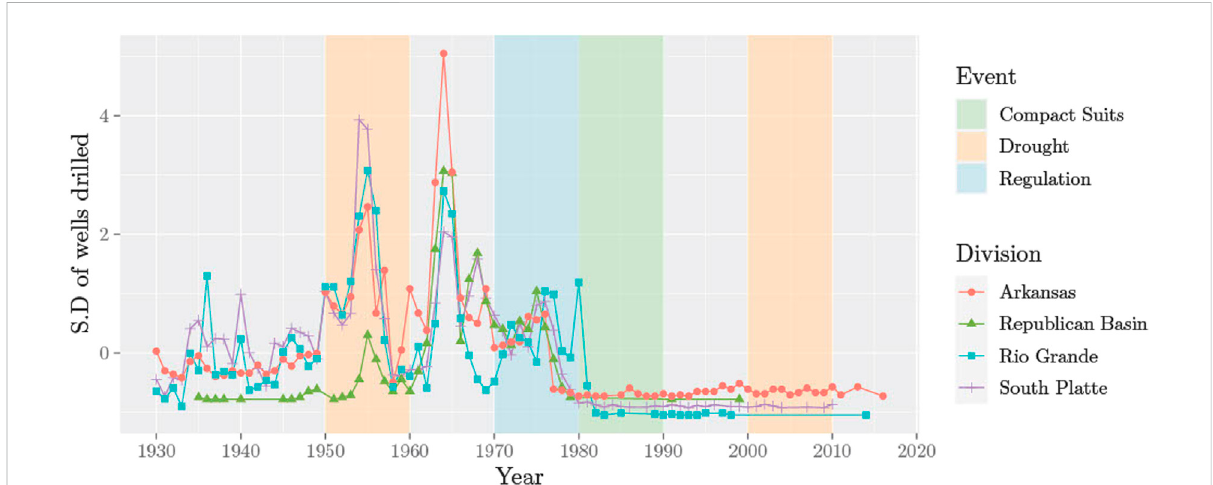
FIGURE 5 The number of new groundwater wells drilled per year in each basin across time for all four study basins. New wells are indicated on the y -axis usingthestandarddeviationofnewwellsdrilledperyearinthatbasinto moreclearlyindicaterelativeannualchangeinnewwells.Groundwaterwell data is estimated based on Colorado state